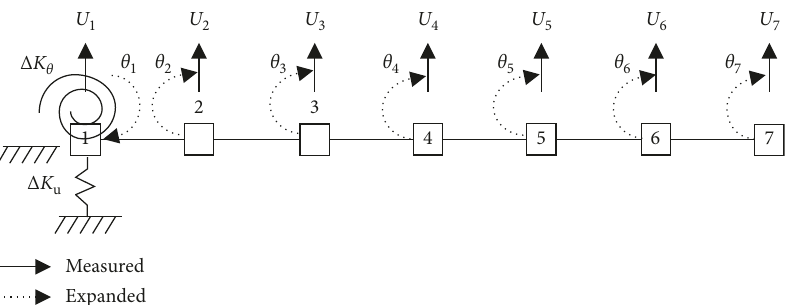
Figure 9: Analytical model for the fixed-free configuration.